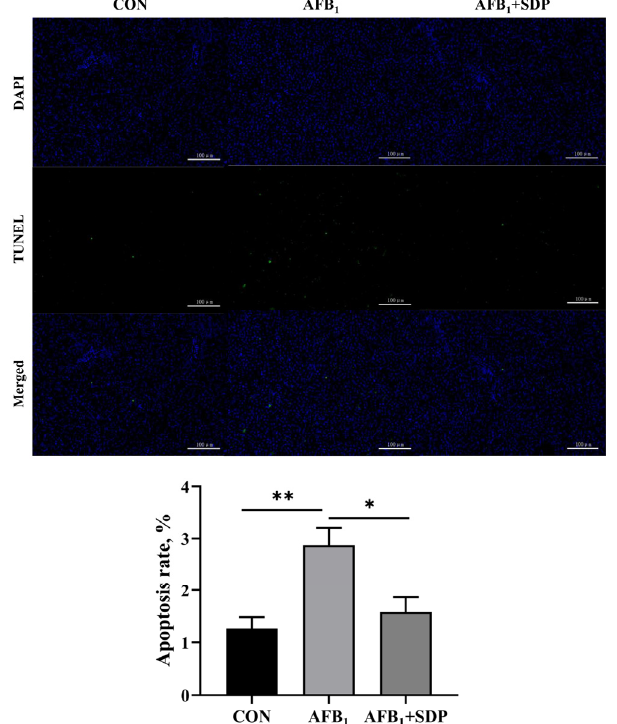
Figure 2. The protective effects of dietary seaweed ( Enteromorpha prolifera ) derived polysaccharides on apoptosis of hepatocytes in broiler chickens. The scale bar is 100 μ m. * p < 0.05, ** p < 0.01, no superscript marks indicated that p > 0.10. CON, control group; AFB 1 group (fed diet with 0.1 mg/kg AFB 1 ); AFB 1 + SDP group (AFB 1 group + 0.25% SDP).